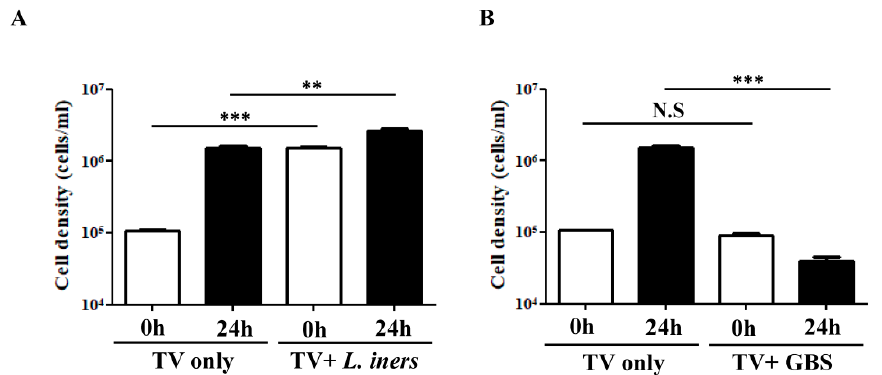
Figure 5. The impact of crosstalk between TV and the associated bacteria on the survival of parasites. TV survival was monitored after co-incubations of TV with L. iners ( A ) and GBS ( B ) at a ratio of 1:10 for 6 h in 1 mL of KSFM medium, followed by inoculation of the microbial cultures into YIS medium. The cell density of TV was monitored by using trypan blue exclusion hemocytometer counts. Quantitative data were presented as mean ± SD of three independent experiments. ** p < 0.01, *** p < 0.001, N.S—not significant.